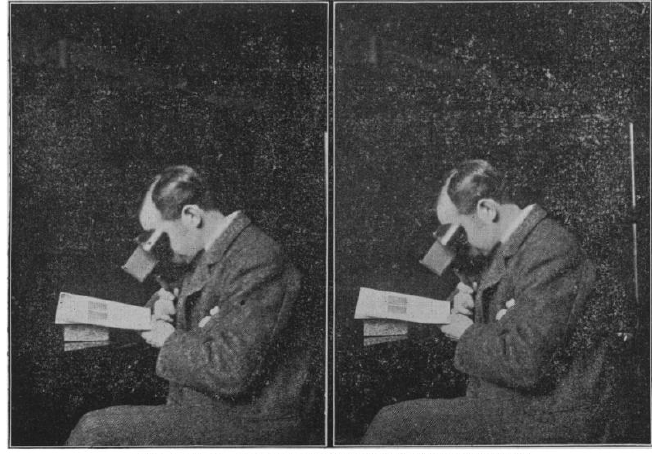
Figure 1 Stereoscope & user (BMJ). Image provided courtesy